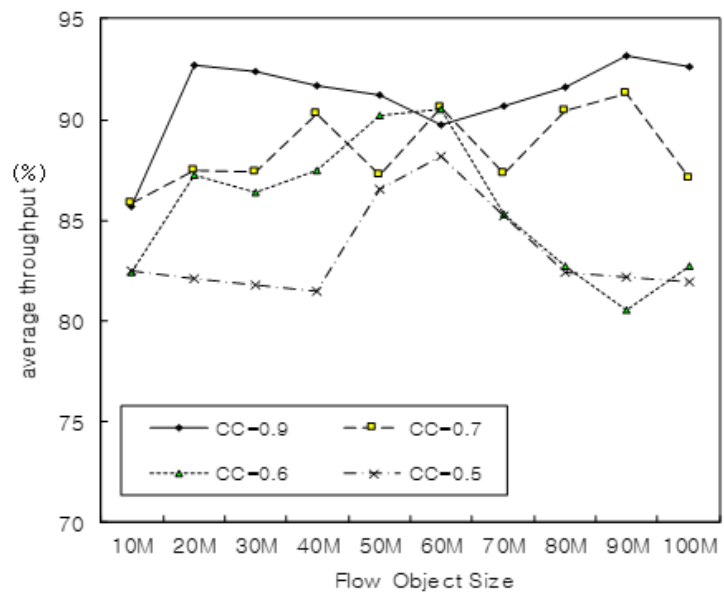
Figure 7. Average throughput with δ and µ